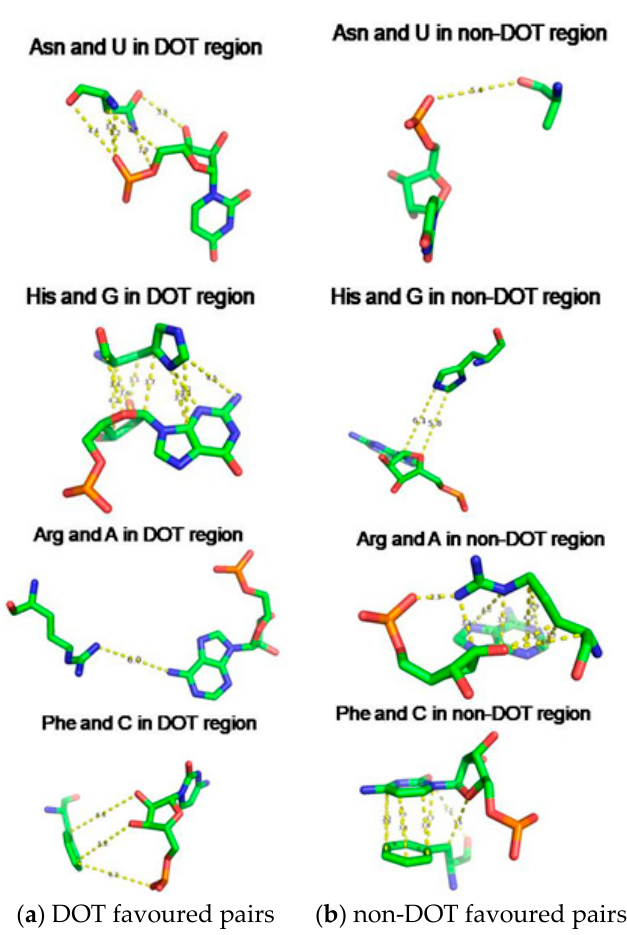
Figure 8. Amino acid showing ( a ) strong interaction in DOT and weak interaction in non-DOT regions and ( b )weak interaction in DOT and strong interaction in non-DOT regions.